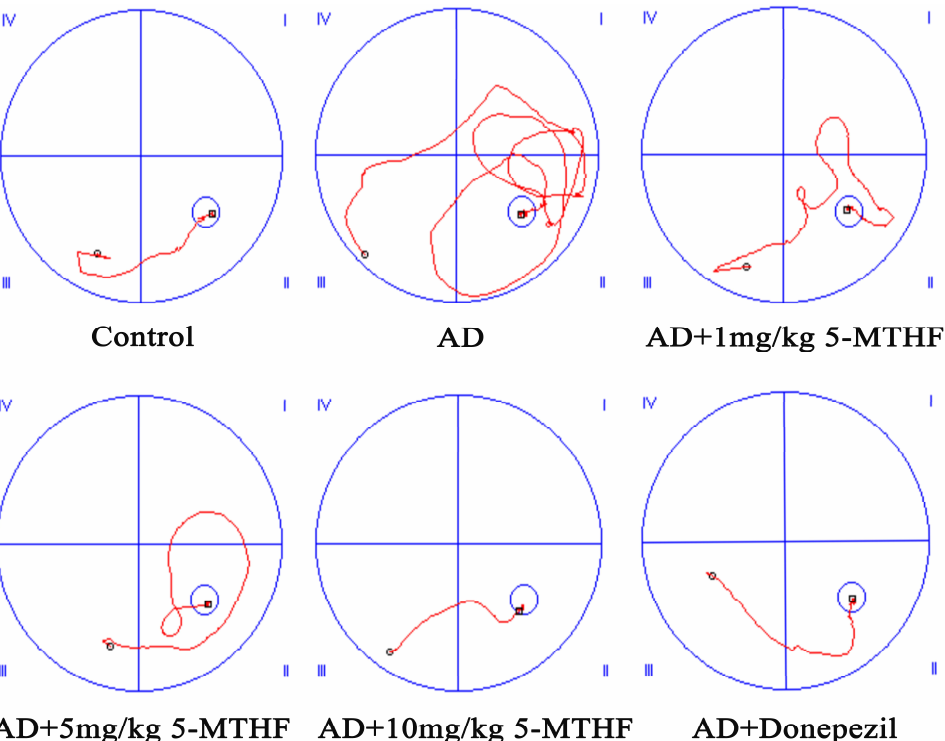
Figure 1. Escape latency was more prolonged for AD rats than for healthy rats by days 2–4 ( p < 0.05), indicating successful AD modeling. Time taken to find the target platform in AD rats dosed with 1, 5 or 10 mg/kg 5-MTHF or donepezil was lower than the untreated AD group on days 3–4 ( p < 0.05, Figure 2a). Platform crossing number and time spent in the target quadrant were both reduced for AD rats compared with controls ( p < 0.01), and all doses of 5-MTHF and donepezil increased these two indicators relative to untreated AD rats ( p < 0.05, Figure 2b,c).